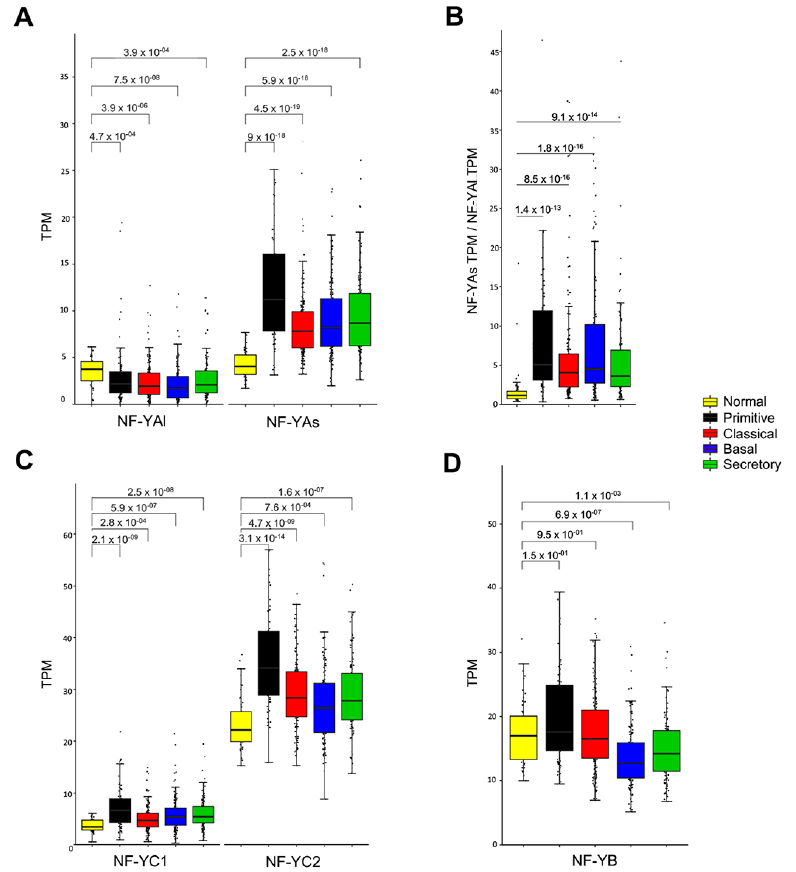
Figure 6. NF-YA is overexpressed in all LUSC subtypes. ( A ) Box plots represent the expression of NF-YA isoforms at gene level in the four LUSC subgroups, measured in TPM. ( B ) NF-YAs/NF-YAl ratios in the four subtypes. ( C ) Box plots represent the expression of NF-YC isoforms at gene level in the four LUSC subgroups. NF-YC1, 50 kD isoform. NF-YC2 37 kD isoform. ( D ) Box plots represent the expression of NF-YB at gene level in the four LUSC subgroups. P values are calculated using a Wilcoxon signed-rank test.